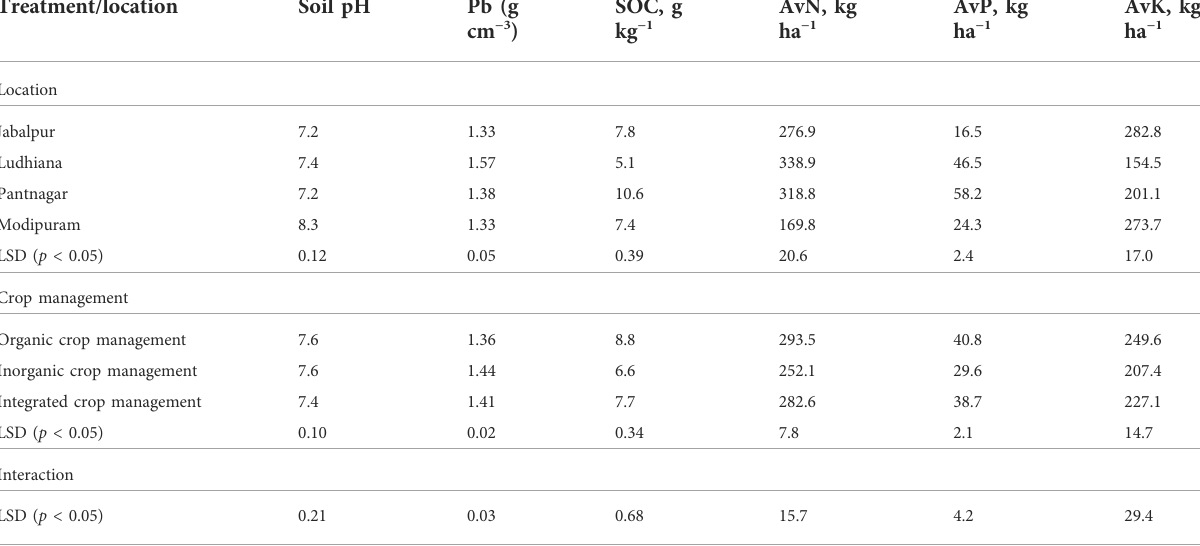
TABLE 2 Effect of spatial and cop management on soil pH, bulk density, soil organic carbon, and nutrients in the rice – wheat system.